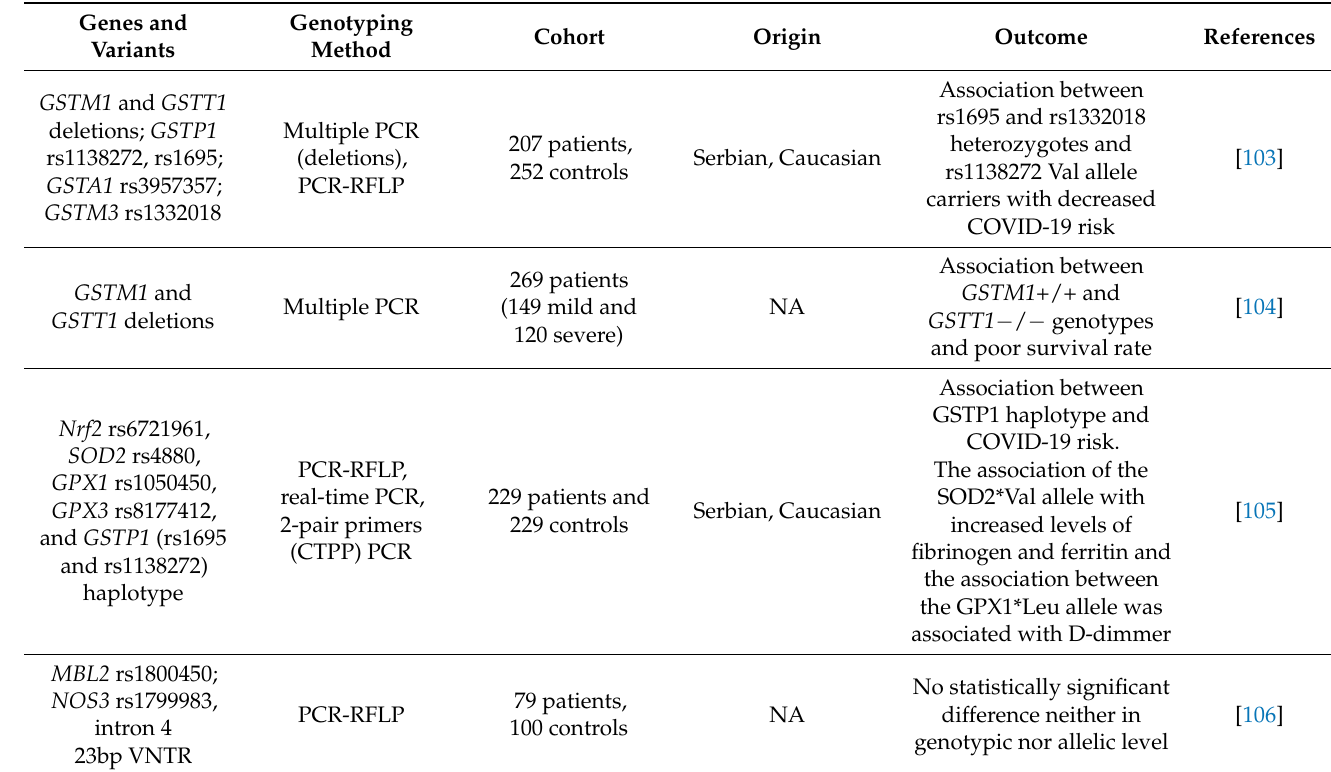
Table 3. Overview of candidate gene studies that involved genes and genetic variants in oxidative stress pathways in COVID-19